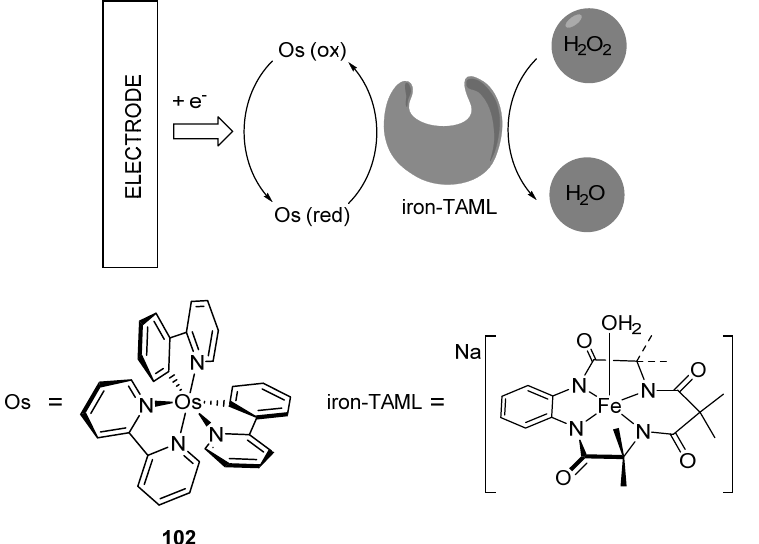
Figure 48. Conceptual principle for a sensor using an iron(III)-TAML catalyst and the bis - osmacy- cle as a mediator.